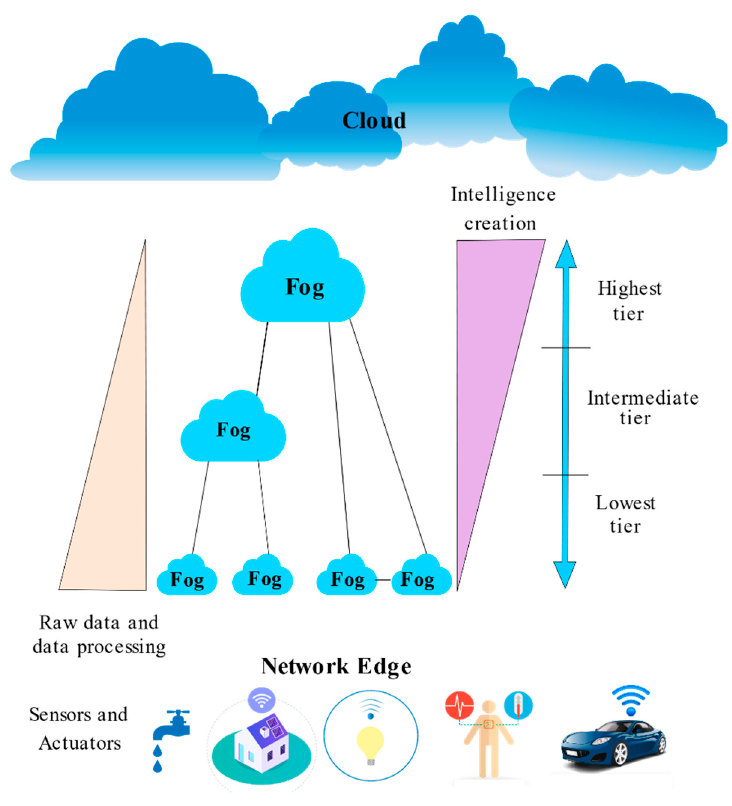
Figure 9. N-tier architecture.